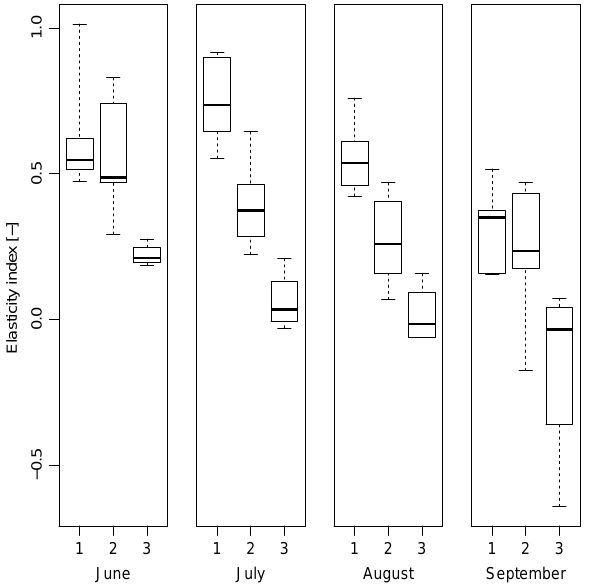
Figure 4. Elasticity index for all catchments classified according to elevation describing the sensitivity of 7-day minimum discharge on maximum SWE for individual months. Elevation classes on x axis: 1, catchments with mean elevation higher than 2000ma.s.l.; 2, catchments with mean elevation between 1300 and 2000ma.s.l.; 3, catchments with mean elevation between 850 and 1300ma.s.l. The boxes represent the 25 and 75% quantiles, with the thick line show- ing the median, and the whiskers represent minimum and maximum values.